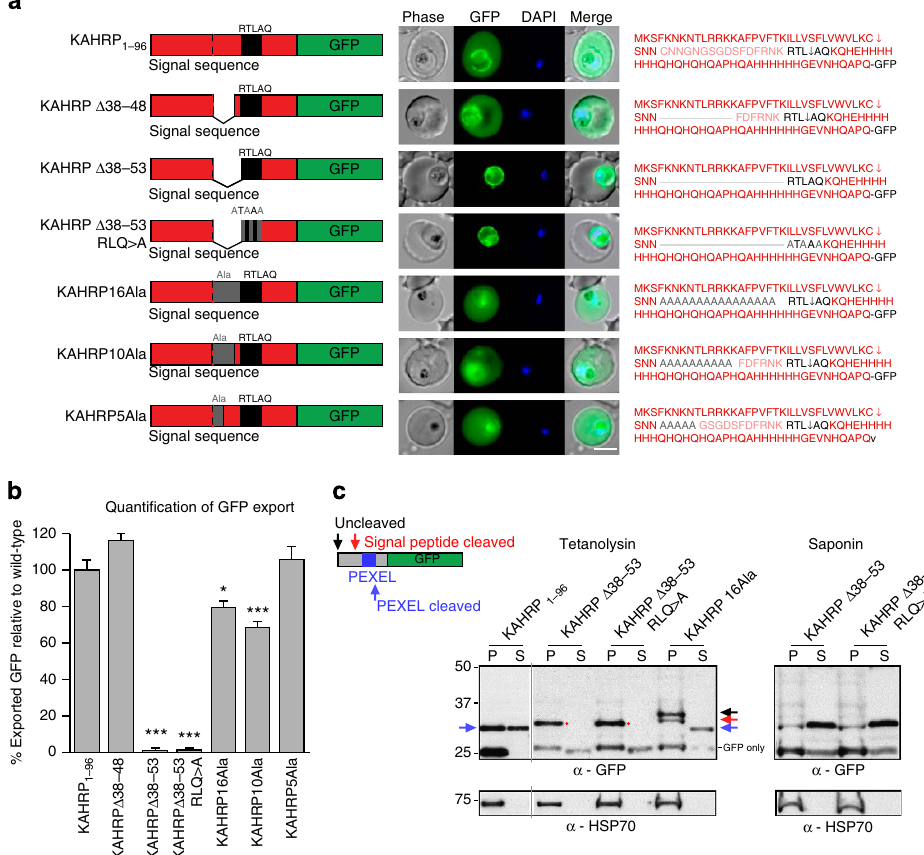
Figure 5 | Correct PEXEL positioning is essential for export. ( a ) KAHRP 1–96 and KAHRP D 38–48 are exported to the P. falciparum -infected erythrocyte but KAHRP D 38–53 and KAHRP D 38–53 RLQ 4 A accumulate in the PV and are not exported. KAHRP16Ala, KAHRP10Ala and KAHRP5Ala are exported to the red blood cell. Scale bar, 5 m m. ( b ) Quantification of export in a . Data are the mean ( ± s.e.m.) GFP fluorescence intensity in the host cell from 20 cells per construct (20 replicates), shown as a percentage of KAHRP 1–96 . Data were analysed by t -test (*** P o 0.0001 and * P o 0.003, compared with KAHRP 1–96 ). ( c ) Immunoblot with anti-GFP antibodies of chimeras from the tetanolysin and saponin pellet (P) and supernatant (S). This shows KAHRP 1–96 at a size corresponding to cleavage at the PEXEL and it was exported (32kDa; blue arrows), KAHRP D 38–53 and KAHRP D 38–53 RLQ 4 E were cleaved to a size corresponding to cleavage by signal peptidase (32.5kDa; red spots) and were not exported, but were present in the saponin supernatant, confirming they were secreted to the PV, and that KAHRP16Ala was of a size corresponding to cleavage at the PEXEL and it was exported (32kDa; blue arrow); however, cleavage was inefficient as bands consistent with signal sequence cleaved (red arrow) and uncleaved (black) species were present in the pellet fraction. HSP70 was used as a control. Full-length gels shown in Supplementary Fig.